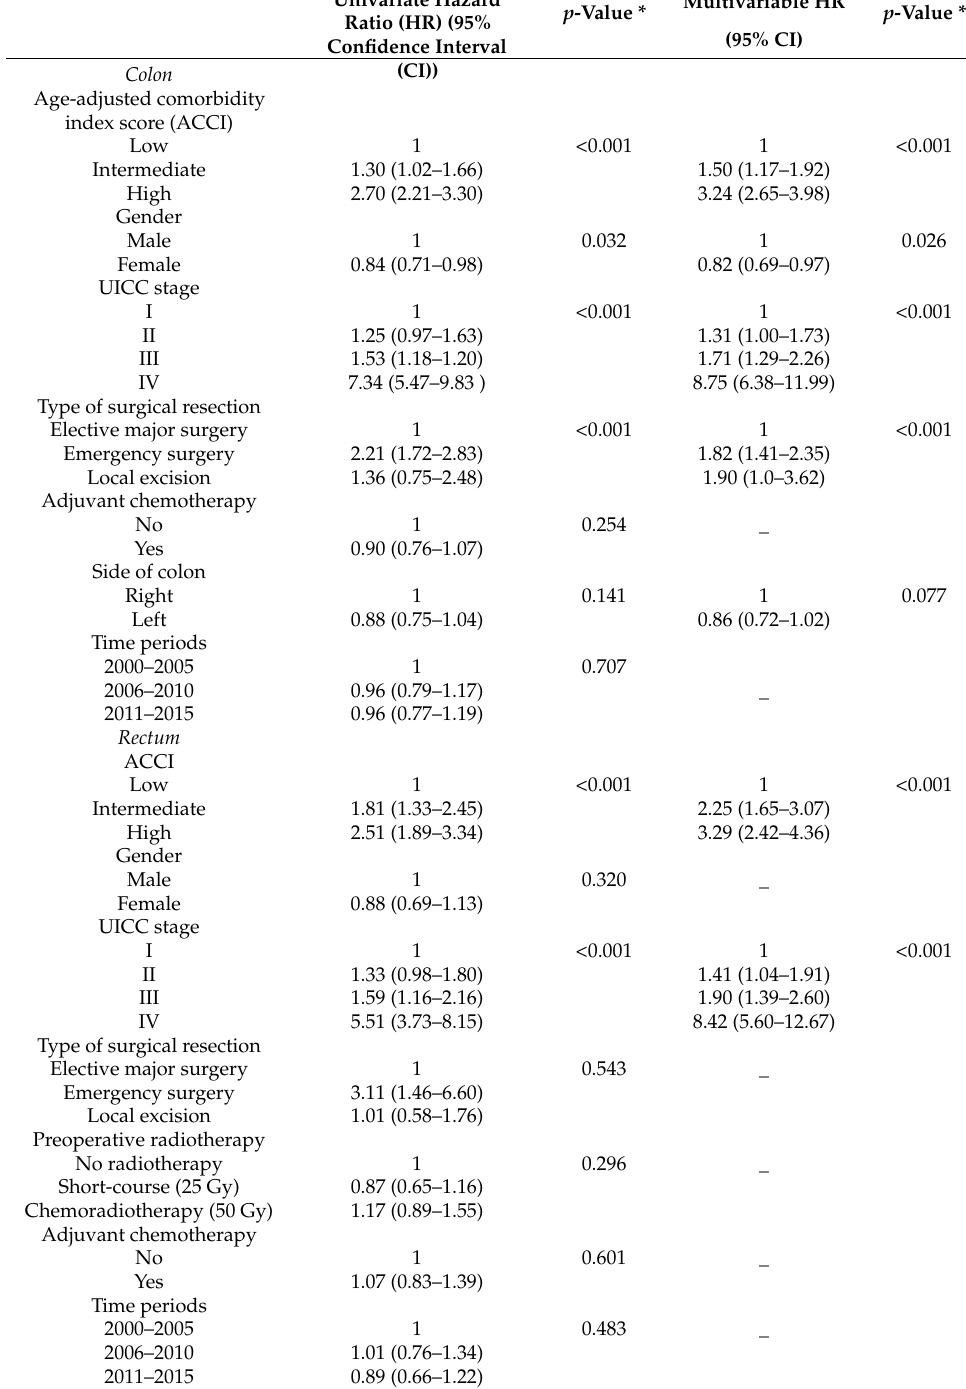
Table 3. Univariate and multivariable Cox proportional hazard analysis for overall